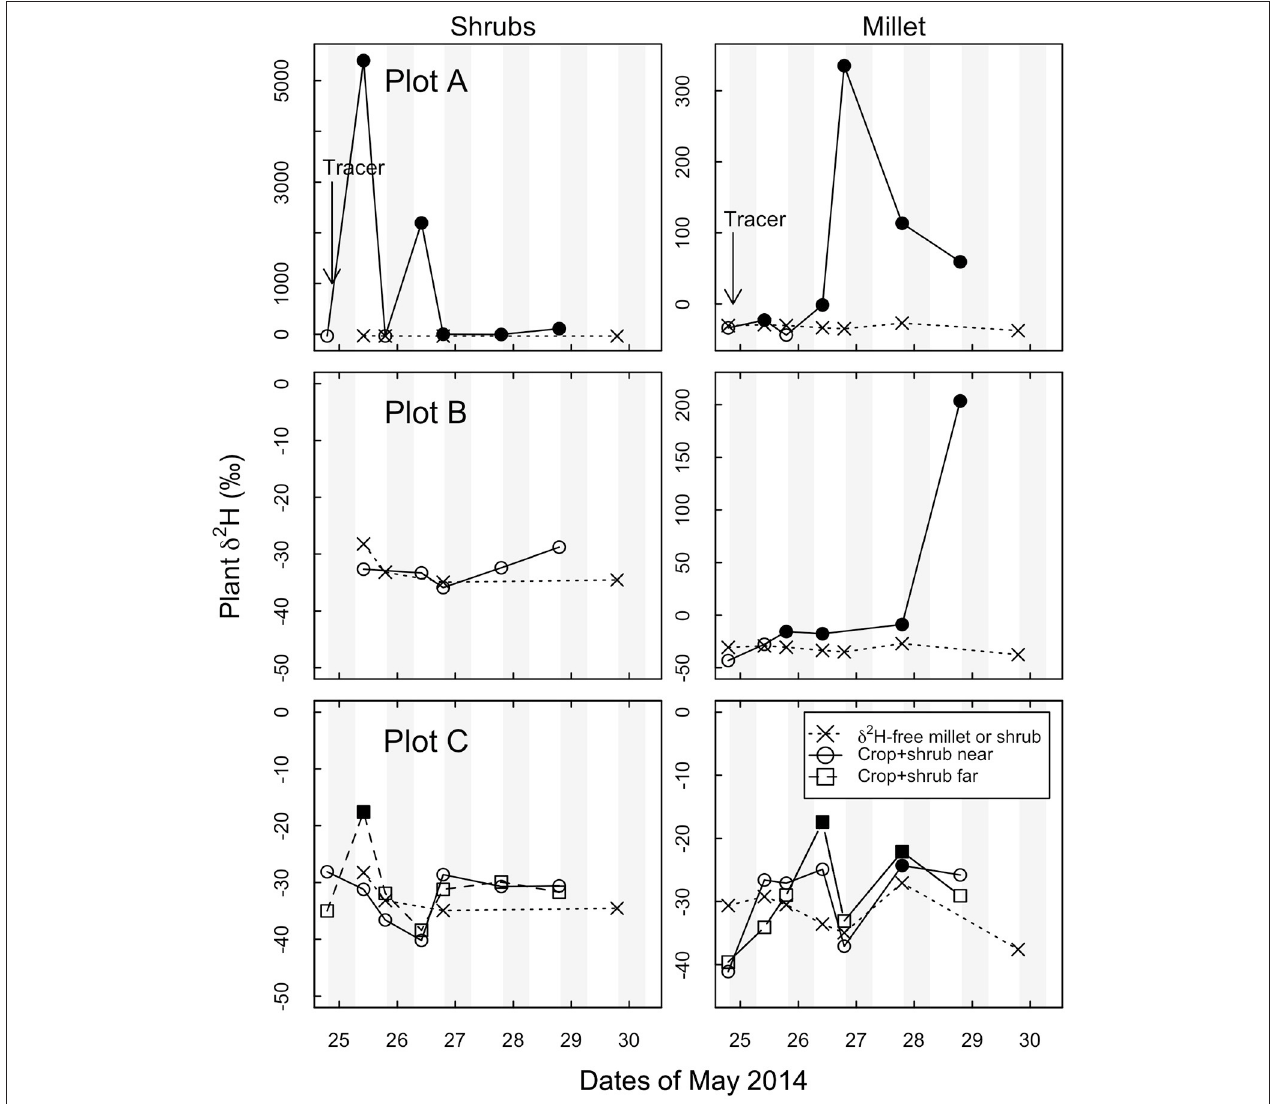
FIGURE 4 | Time evolution in δ 2 H in shrub ( Guiera senegalensis ) and crop ( Pennisetum glaucum) plant water in each of three crop + shrub subplots and in a separate δ 2 H-free crop and δ 2 H-free shrub located at least 30m from nearest enriched tracer site. “Tracer” indicates the beginning of the stable isotope 2 H-tracer study on the evening of May 24. Crop + shrub subplot (A,B,C) “near” were taken < 0.5m from δ 2 H labeled shrub. Crop + shrub subplot C “far” was 4.5m to the East of the δ 2 H labeled shrub. Shaded portions indicate night time hours. Note different y-axis scales. Open symbols represent background δ 2 H signal, and filled symbols represent above background δ 2 H signal, “x” symbols represent data from δ 2 H-free control millet plot and shrub plot.